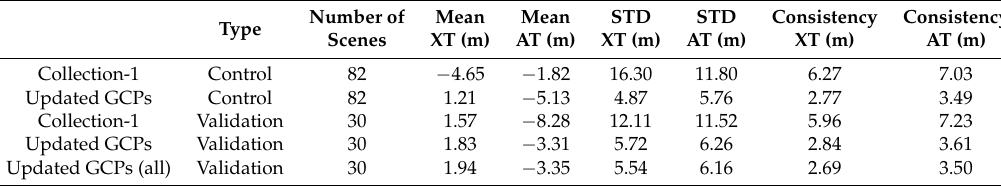
Table 13. Validation of the GCP updates using the geodetic accuracy validation procedure for the Islands block.